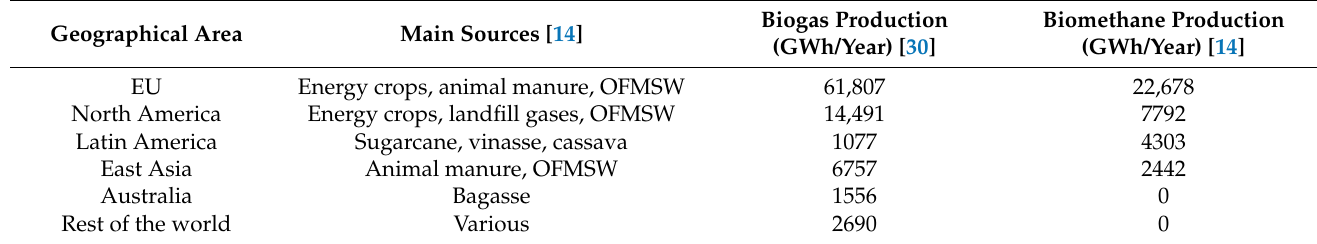
Table 1. Biogas and biomethane data in the main geographical